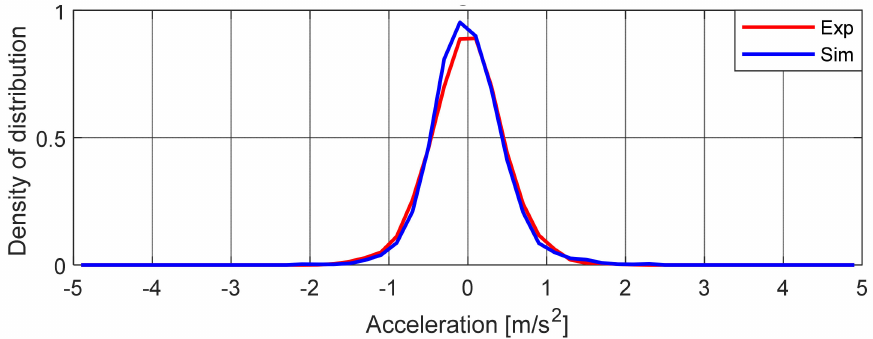
Figure 16. Density of probability distribution, acceleration in vehicle CG.